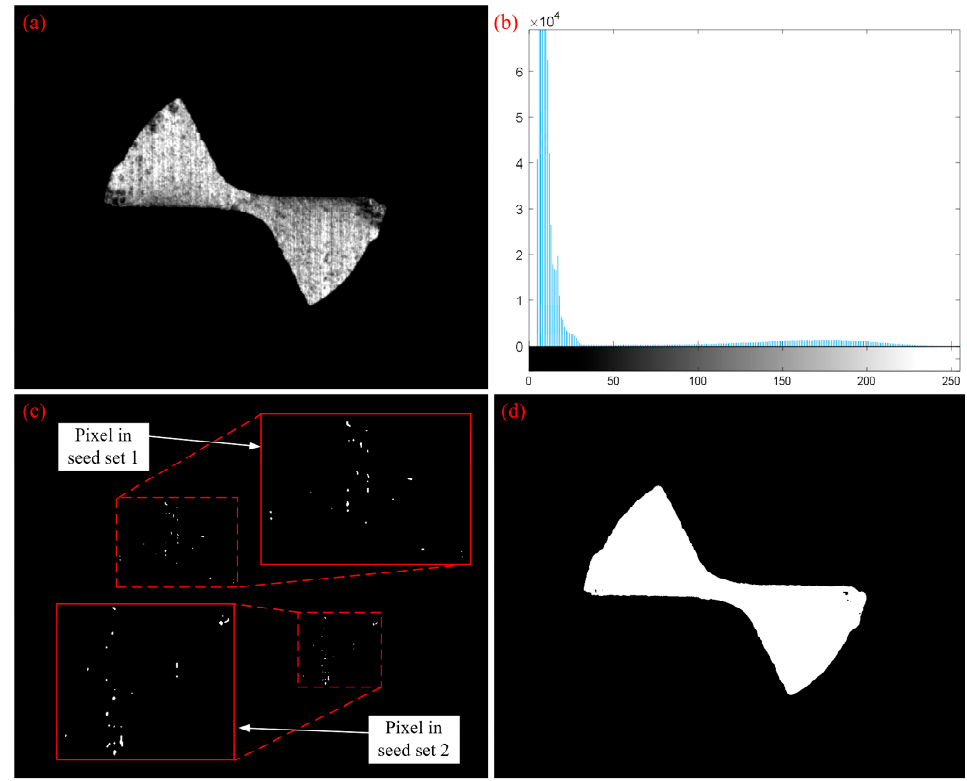
Figure 11. Tool wear image segmentation based on region growing method: ( a ) denoised tool wear image;( b ) a gray level histogram of Figure 11a ( c ) seed pixel selection image; ( d ) segmented image.